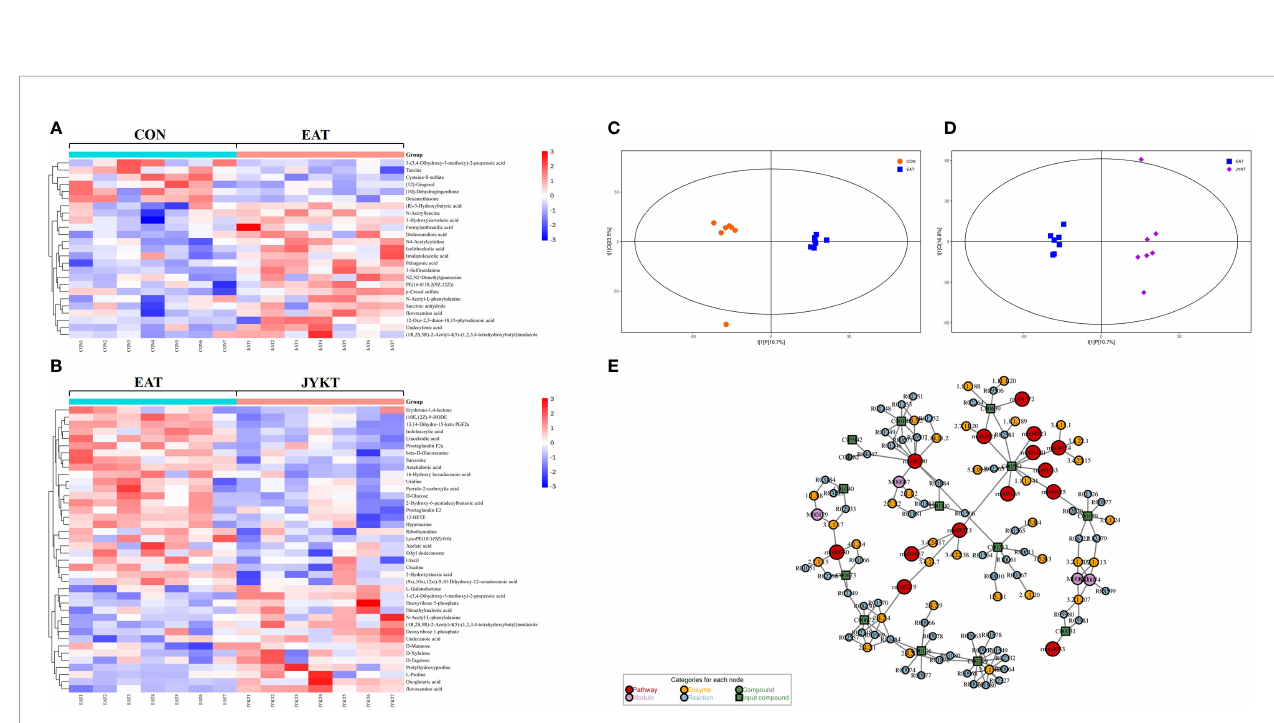
FIGURE 6 | Heatmaps of differential metabolites between the CON and EAT group (A) , and between the EAT and JYKT group (B). OPLS-DA score plots between the CON and EAT group (C) , and between the EAT and JYKT group (D) . Network analysis between the EAT and JYKT group (E)